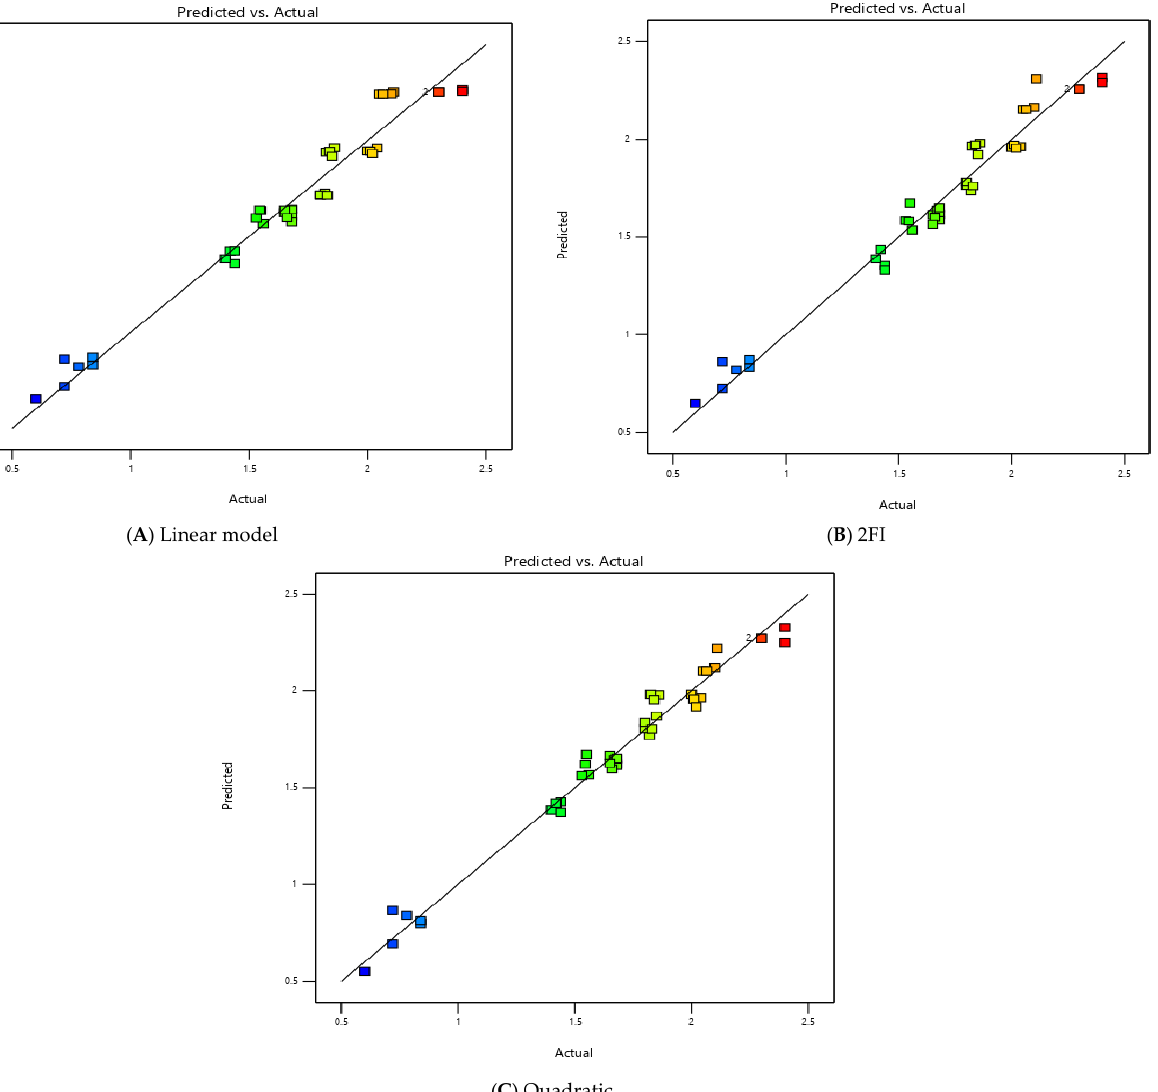
Figure 8. The scatter plot of the predicted vs. actual values for linear, 2FI, and quadratic models. ( A ) Linear model ( B ) 2FI model ( C ) Quadratic model.